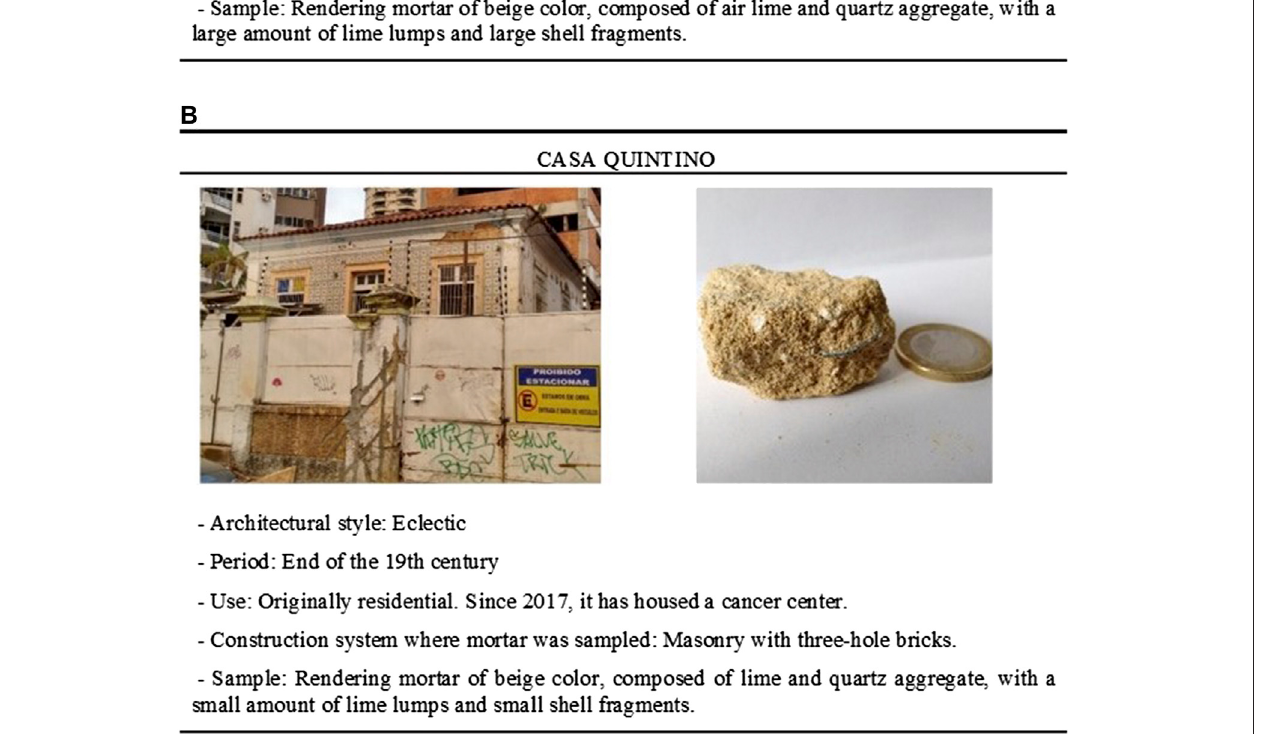
FIGURE 1 | Description of buildings selected for sample